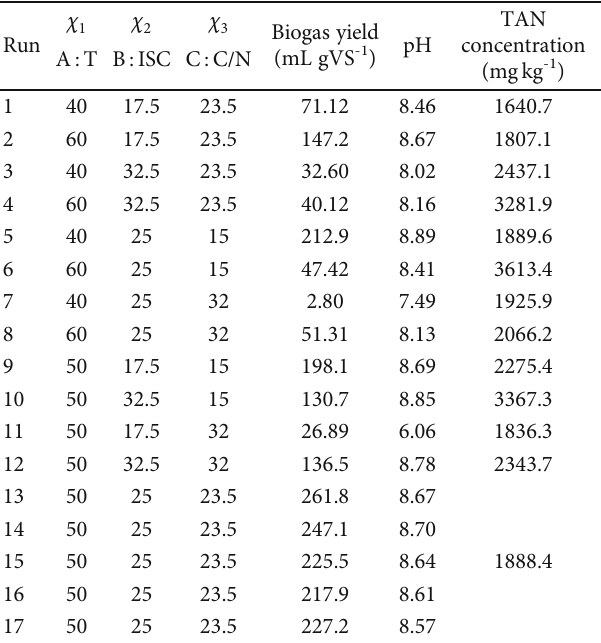
Table 3: E ff ect of T, ISC, and C/N ratio on the biogas yield, pH, and TAN concentration after 20 d of SS-AD. χ χ 1 Run